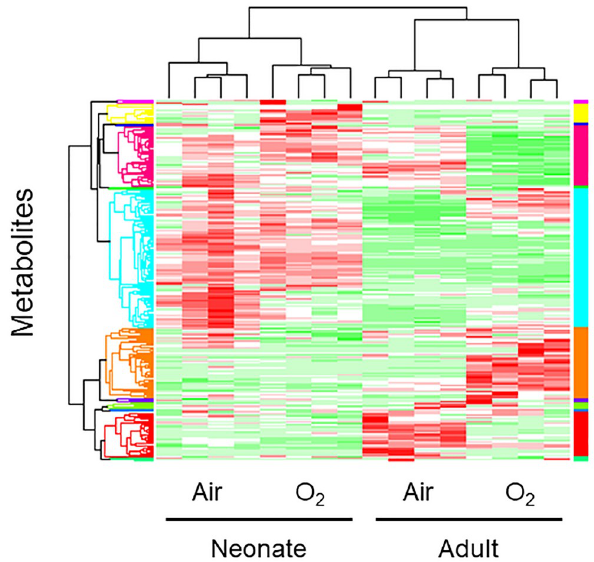
Fig 1. Visualization of the profiles of the detected metabolites uasing a heat map. Columns represent individual mice, and row represent specific metabolites. The color scale from green to red indicates relative changes in the levels of the detected metabokites. Red indicates that the relative level of the metabolite is higher than the average, and green indicates that the relative level of the metabolite is lower than the average. Lungs were obtained from four different groups of mice: room air newborn, high O 2 concentration newborn, room air adult, and high O 2 concentration adult groups. The four major clusters distinguished by HCA are coincident with the four groups.